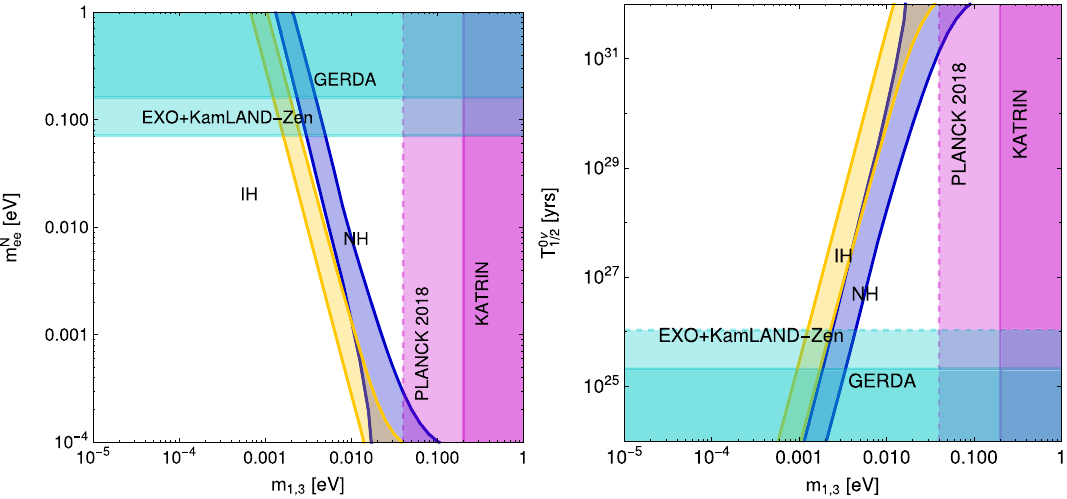
show the limits on effective Majorana mass and half-life from GERDA and EXO+KamLAND-Zen experiments. The vertical purple bands are for the constraints on sum of light neutrino masses from cosmology data (PLANCK 2018) and KATRIN detector